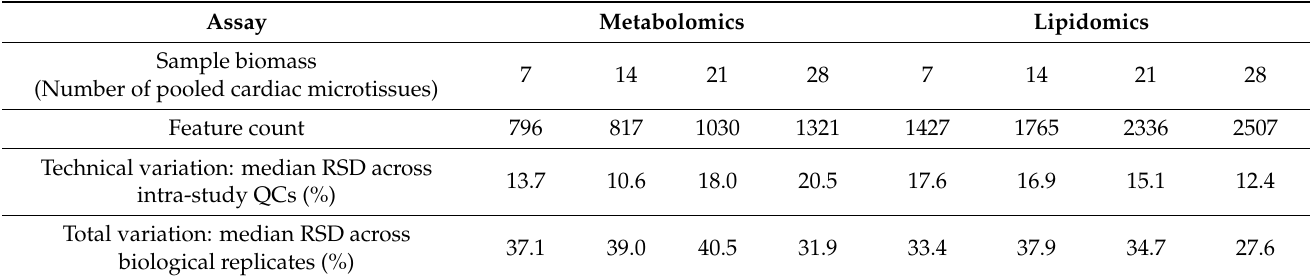
Table 2. Metrics to evaluate the detection sensitivity (feature count), technical reproducibility (mRSD across intra-study QCs) and total reproducibility (mRSD across biological replicates) of measurements are reported for samples of 7, 14, 21 or 28 pooled cardiac microtissues analysed by nESI-DIMS metabolomics and lipidomics (positive ion mode). Assay